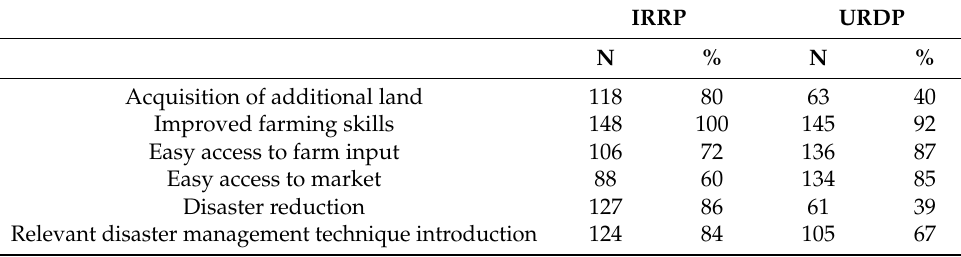
Table 4. Additional benefits to agriculture